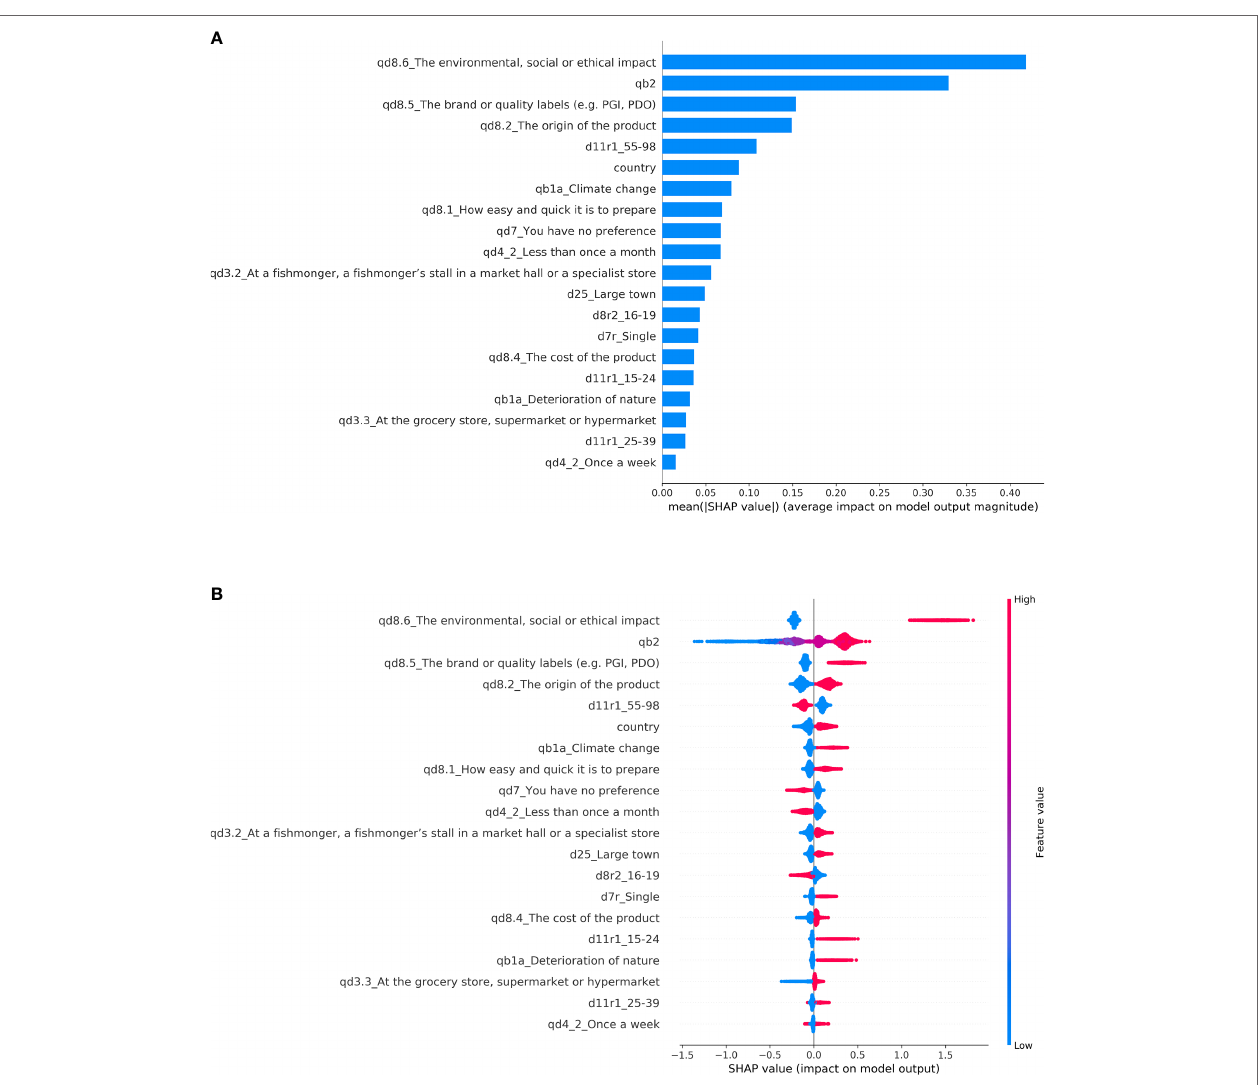
FIGURE 2 | Feature importance and summary plot. (A) SHAP feature importance, (B) Distribution of the SHAP values per feature.